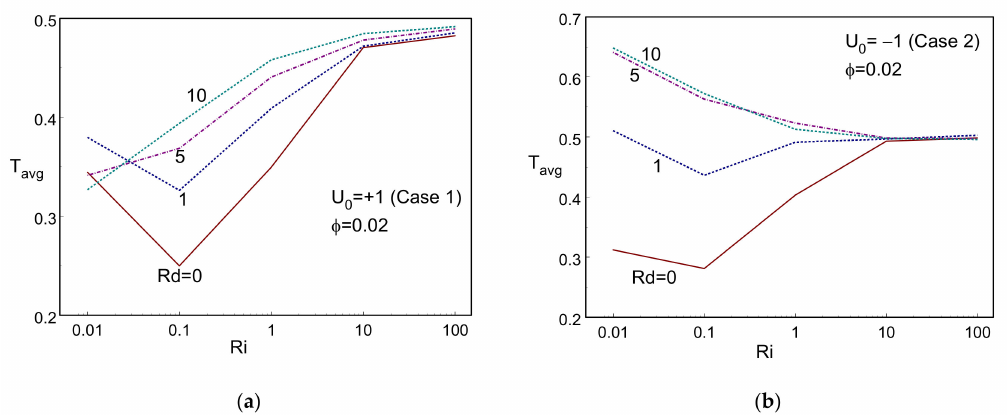
Figure 12. Averaged temperature for di ff erent Ri and Rd values. ( a ) Case 1; ( b ) Case 2.